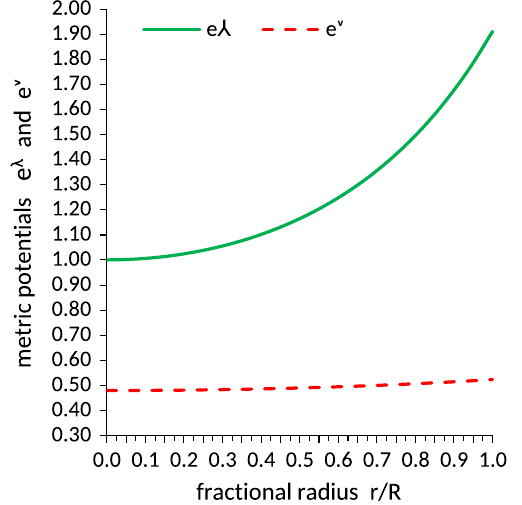
Fig. 1 Behavior of the metric potentials ν and λ with respect to fractional radial distance ( r / R ) for RX J 1856-37. For plotting this figure, the numerical values of the parameters are taken as follows: n = 1, m = 5, N = 11, a = 1, b = 0 . 25, K = 0 . 11, β = 4 . 2395, A = 1 . 1426, B = 0 . 4798, C = 2 . 3113 × 10 − 3 (Table